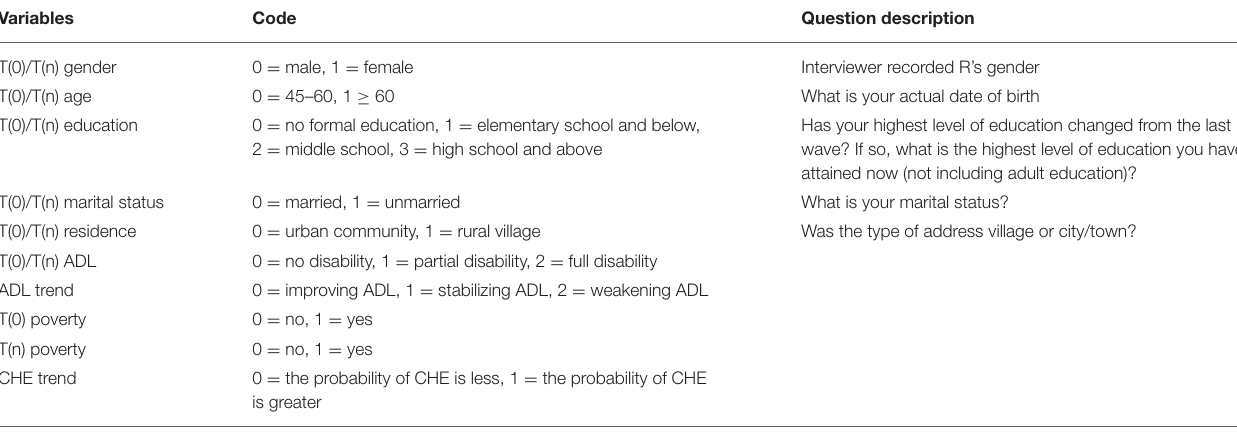
TABLE 1 | Code and question description of variables.